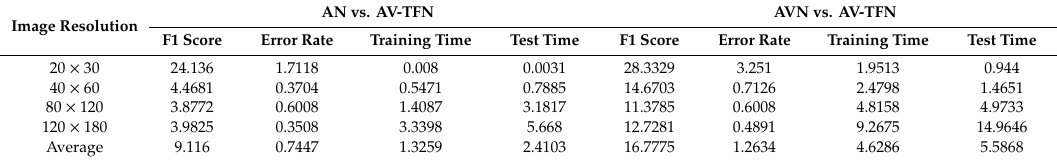
Figure 10. Experiment results of AN, Audio-Visual Network (AVN), AV-TFN as image resolution increases: ( a ) F1 score; ( b ) error rate; ( c ) training time; ( d ) test time. Table 4. Superiority of AV-TFN compared with AN and AVN.